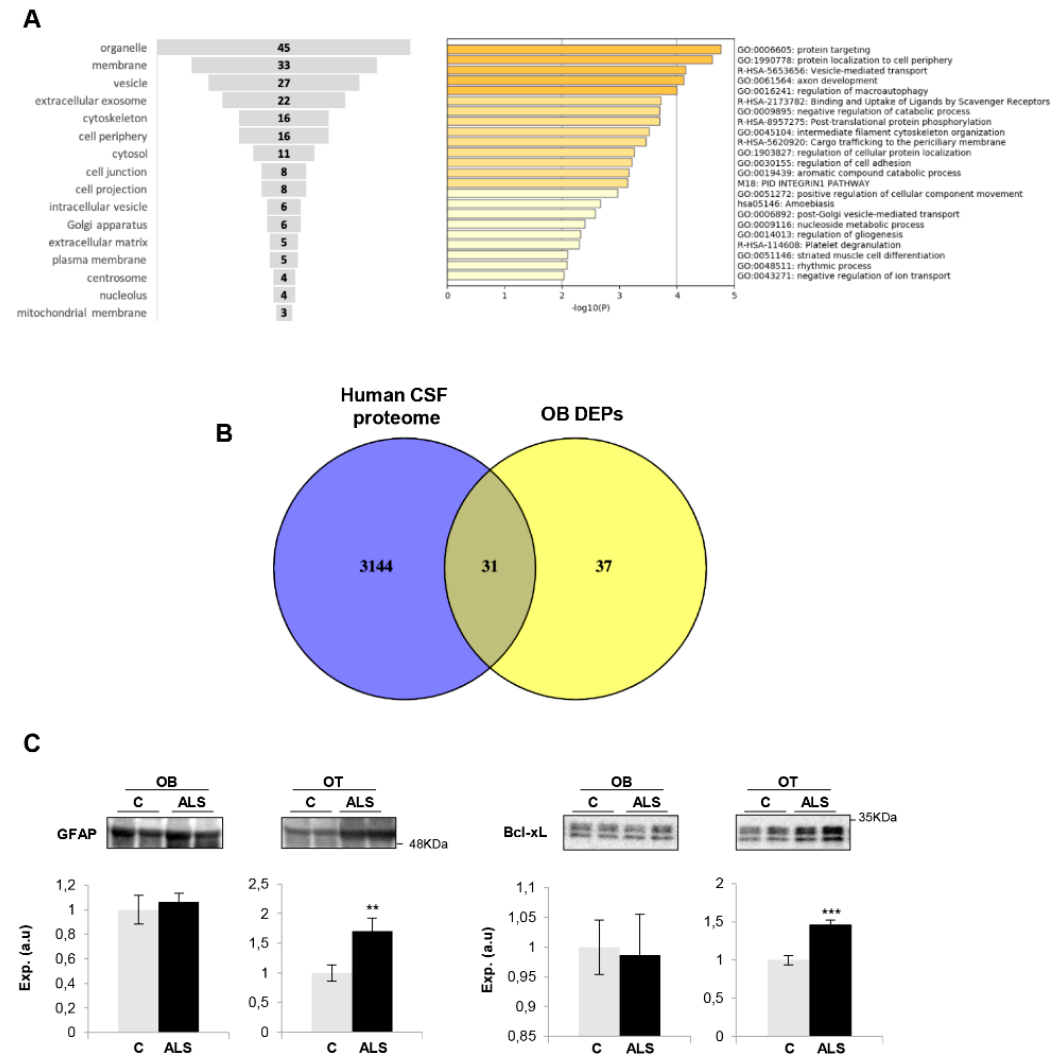
Figure 3. ( A ) Functional analysis of OB di ff erentially expressed proteins in ALS.